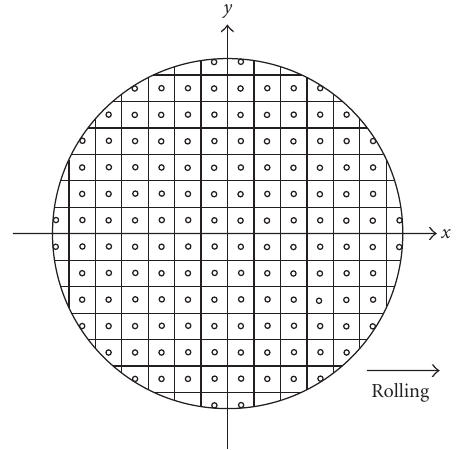
Figure 7: The discretization of the contact patch.